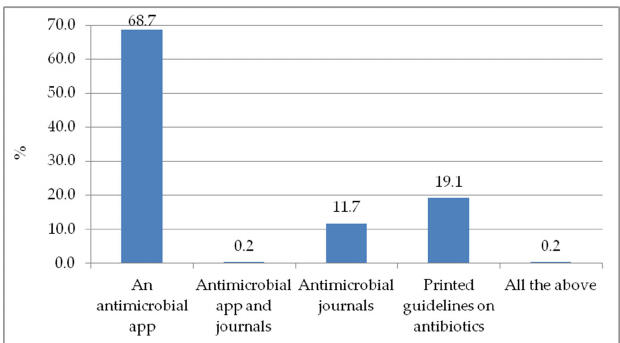
Figure 2. Educational tools that will be part of my regular learning, if available.